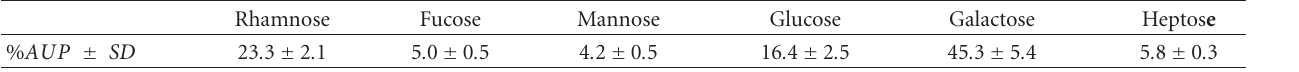
Table 1: Quantities of carbohydrates in polysaccharide chain of D. desulfuricans endotoxin. Rhamnose Fucose Mannose Glucose Galactose Heptos e